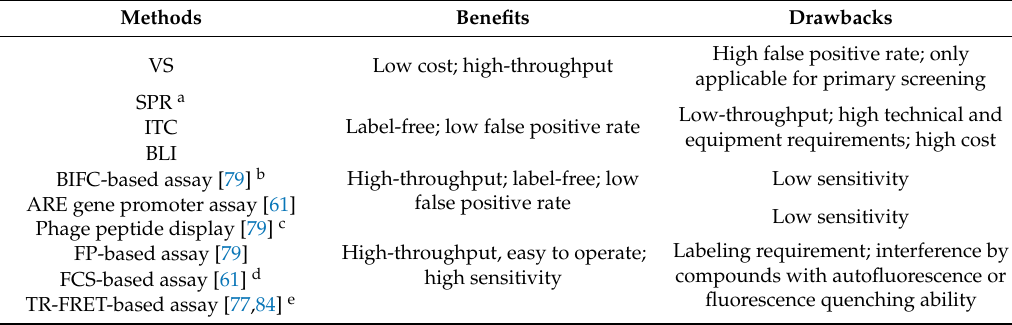
Table 2. Comparison of di ff erent approaches for developing Keap1-Nrf2 PPI inhibitors.